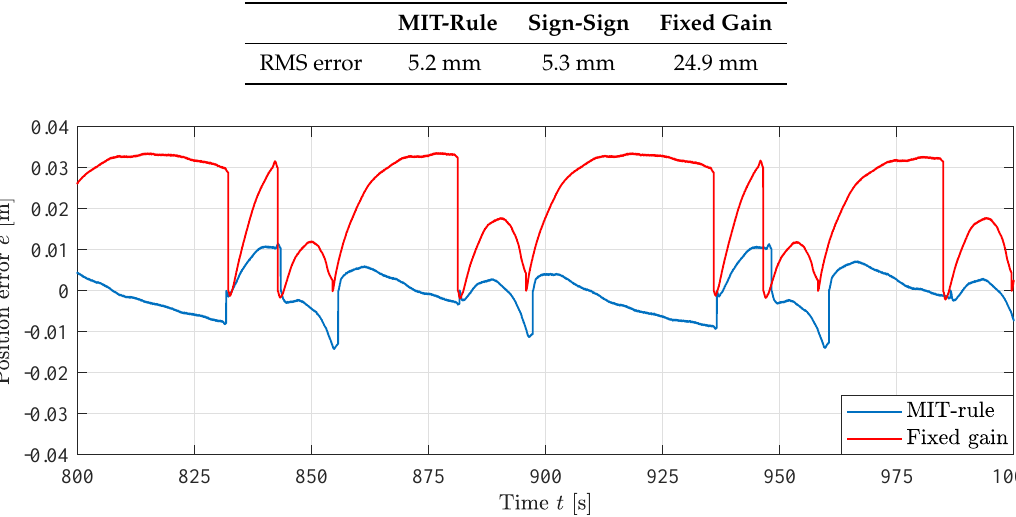
Table 5. Comparison of RMS position error after convergence in experiment.